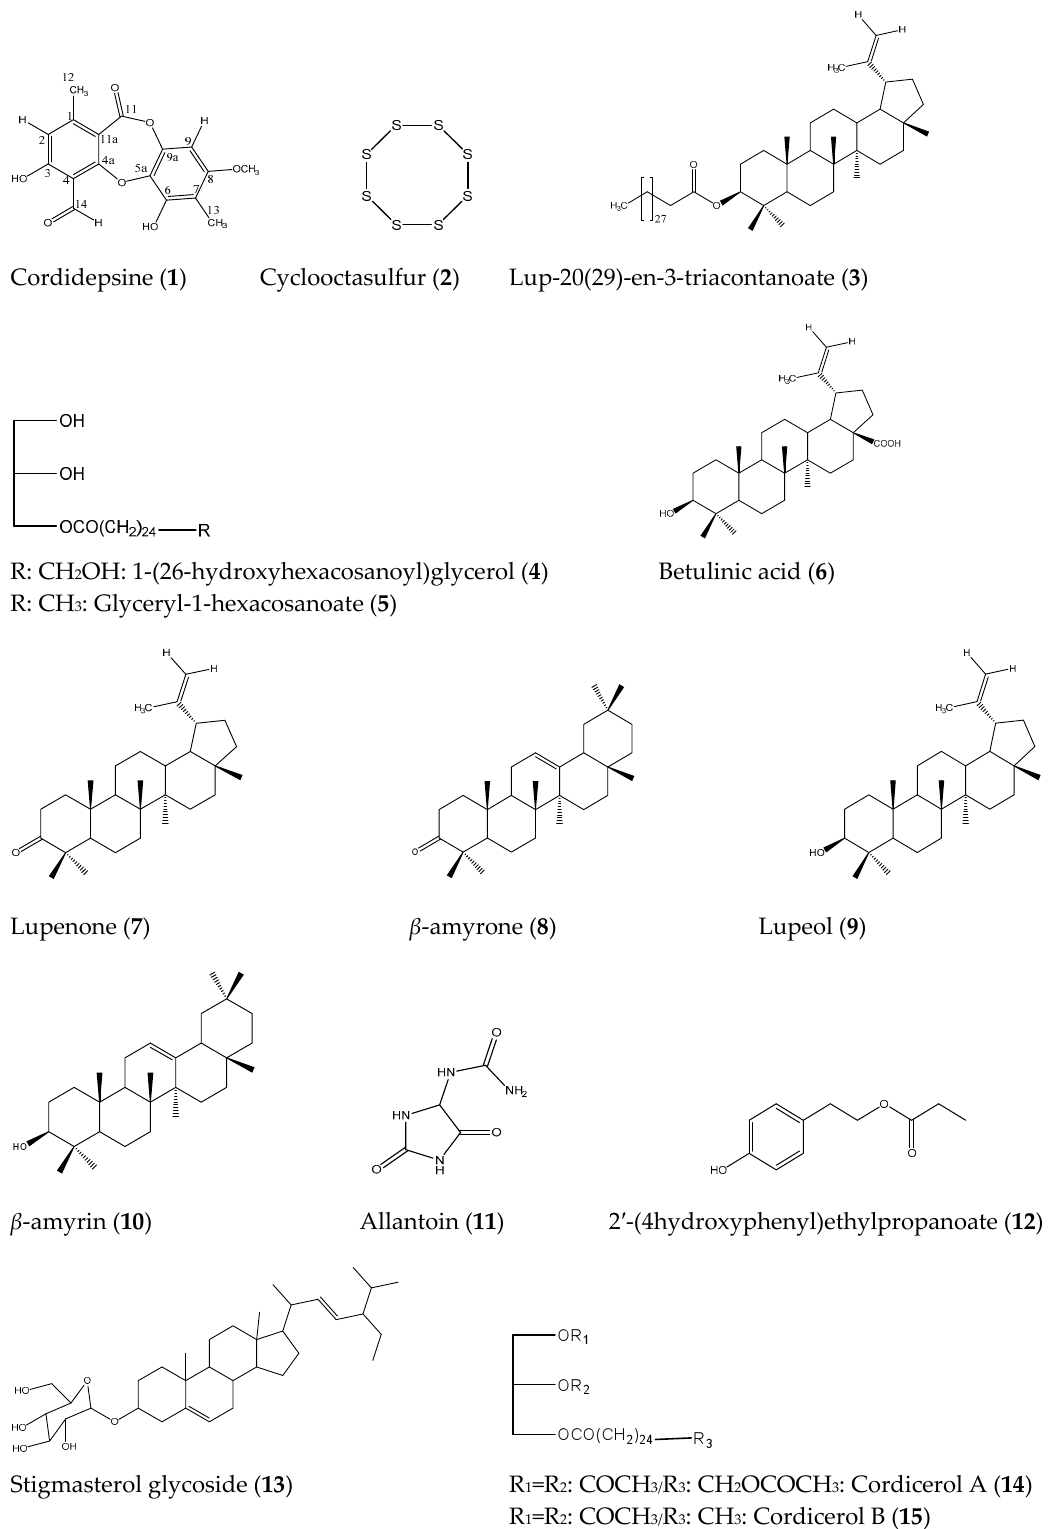
Figure 1. Chemical structures of compounds.